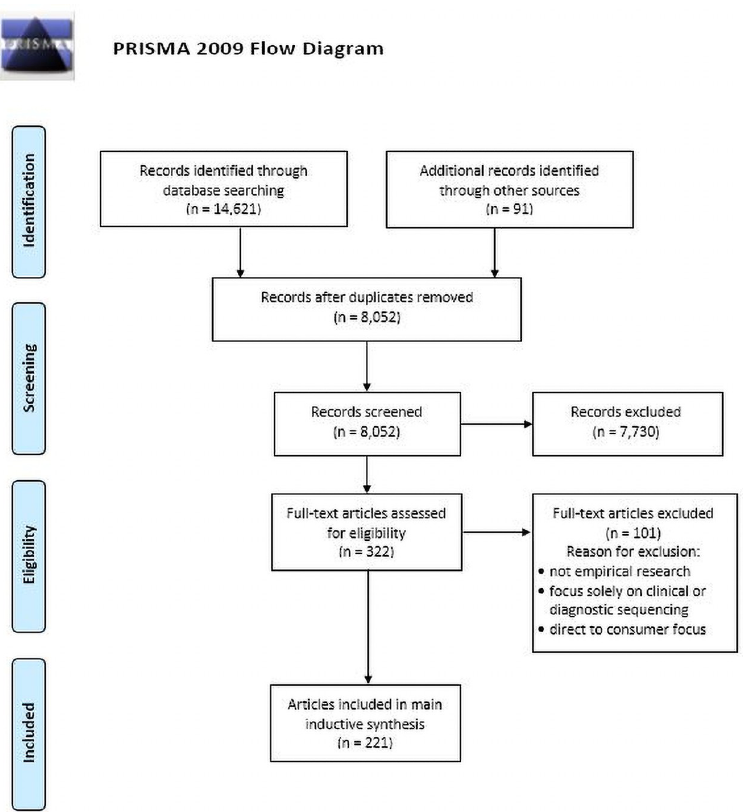
Fig 1. PRISMA flowchart. From : Moher D, Liberati A, Tetzlaff J, Altman DG, The PRISMA Group (2009). P referred R eporting I tems for S ystematic R eviews and M eta- A nalyses: The PRISMA Statement. PLoS Med 6(7): e1000097. doi:10.1371/journal.pmed1000097 For more information, visit www.prisma-statement.org.